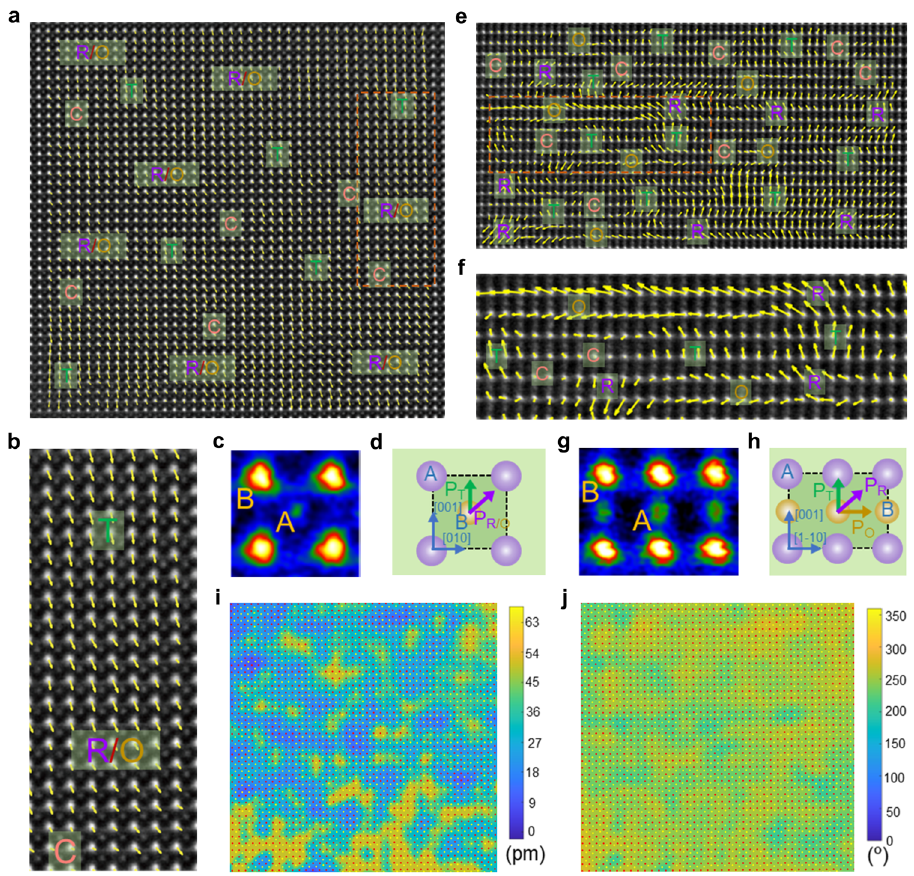
Fig. 2 R-O-T-C multiphase nanoclusters coexistence. a Atomic-resolution HAADF STEM polarization vector image along [100] c . b Enlarged image of the marked area (dark red rectangle) in a showing the transition of polarization vectors from T to R/O to C. c Magni fi ed image and d schematic projection of the unit cell along [100] c . e Atomic resolution HAADF STEM polarization vector image along [110] c . f Enlarged image of the marked area (dark red rectangle) in e showing the transition of polarization vectors from T to R to O to C. g Magni fi ed image and h schematic projection of the unit cell